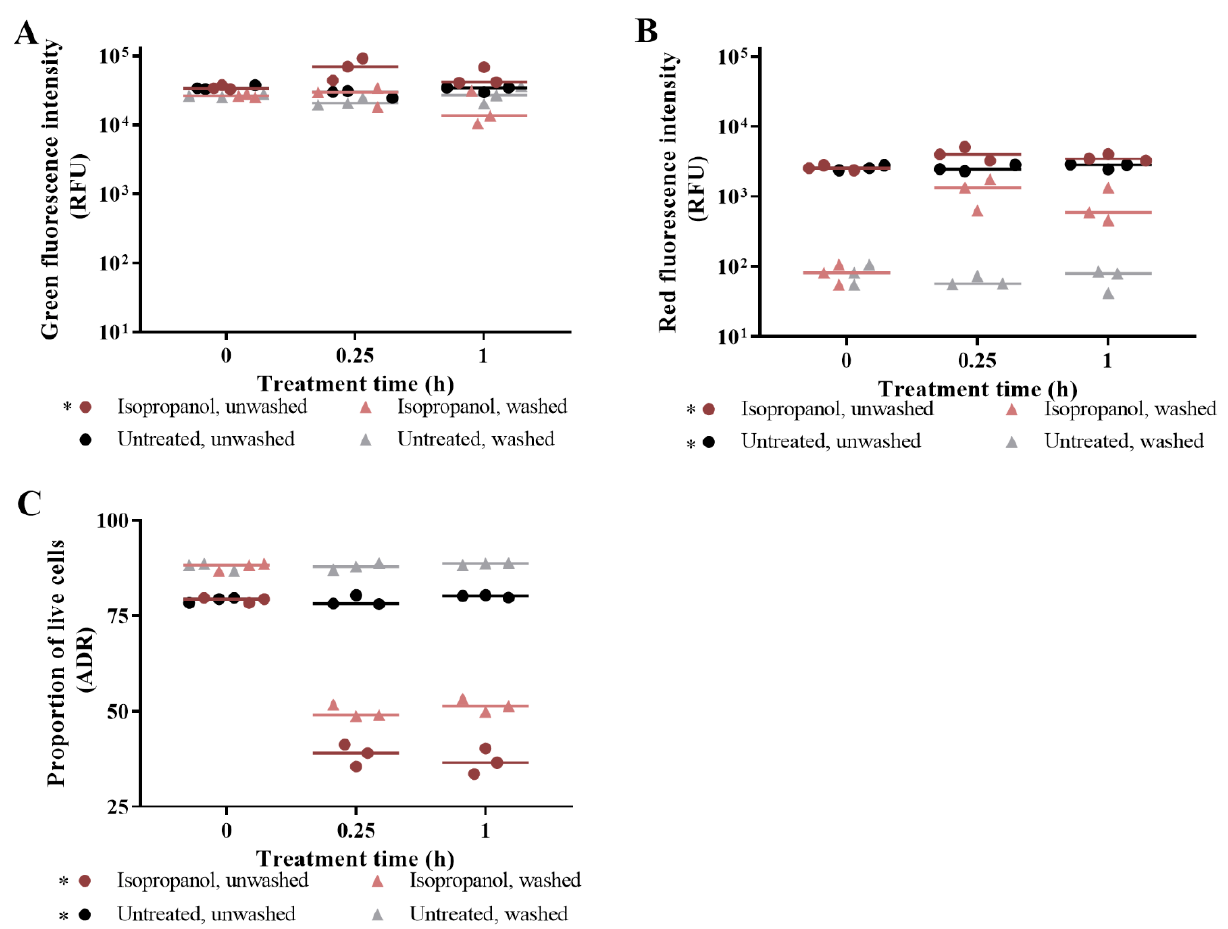
Figure 2. The impact of post-staining washing of isopropanol-challenged E. coli . The effect of washing aliquots after staining is presented for SYTO 9-stained cells ( A ); PI-stained cells ( B ); and SYTO 9- and PI-stained cells ( C ). E. coli was challenged with isopropanol (brown) or nothing (untreated; black/grey), and samples were taken at 0 h (pre-treatment), 0.25 h, and 1 h. Following staining of duplicate aliquots with SYTO 9 and/or PI, and one aliquot was left unwashed and the other aliquot was washed in fresh MM. Fluorescence intensities were obtained from integrating at 505–515 nm for green emissions and 600–610 nm for red emissions. The adjusted dye ratio (ADR) was calculated using the green and red emissions from SYTO 9- and PI-stained samples to indicate the proportion of live cells in the aliquot. Each dot represents a biological replicate, and the median is shown by the line. Statistical significance between washed and unwashed samples is represented by * (two-way RM ANOVA, p value: <0.05, Tukey multiple comparisons test).